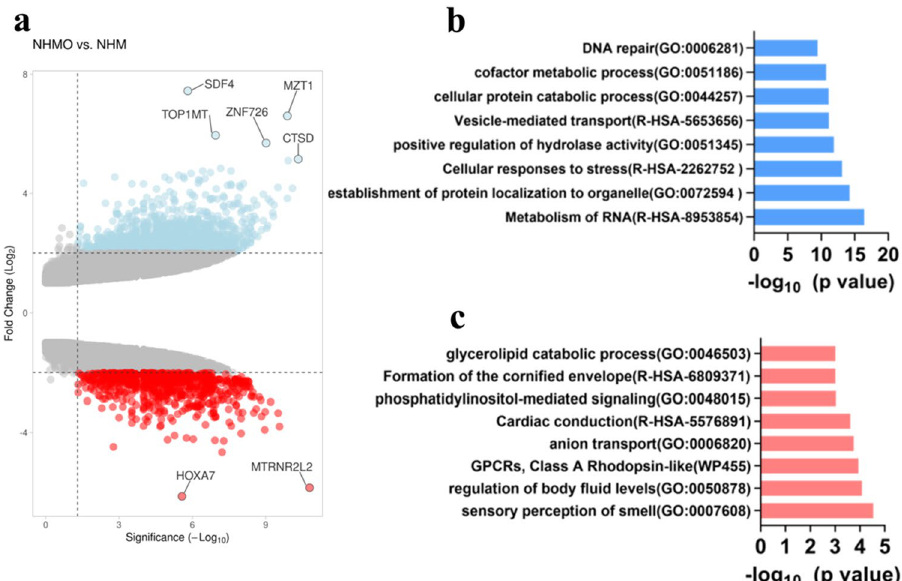
Figure 4. ( a ) Volcano plot depicts differentially expressed genes in NHMO vs NHM (red = downregulated, blue = upregulated), ( b ) top upregulated gene ontology terms, ( c ) top downregulated gene ontology terms.